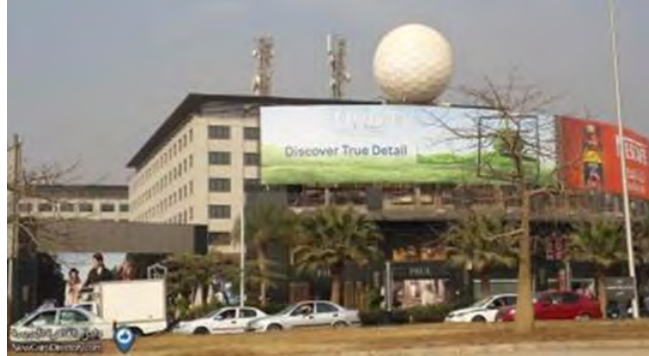
Figure 7. Downtown Mall Media